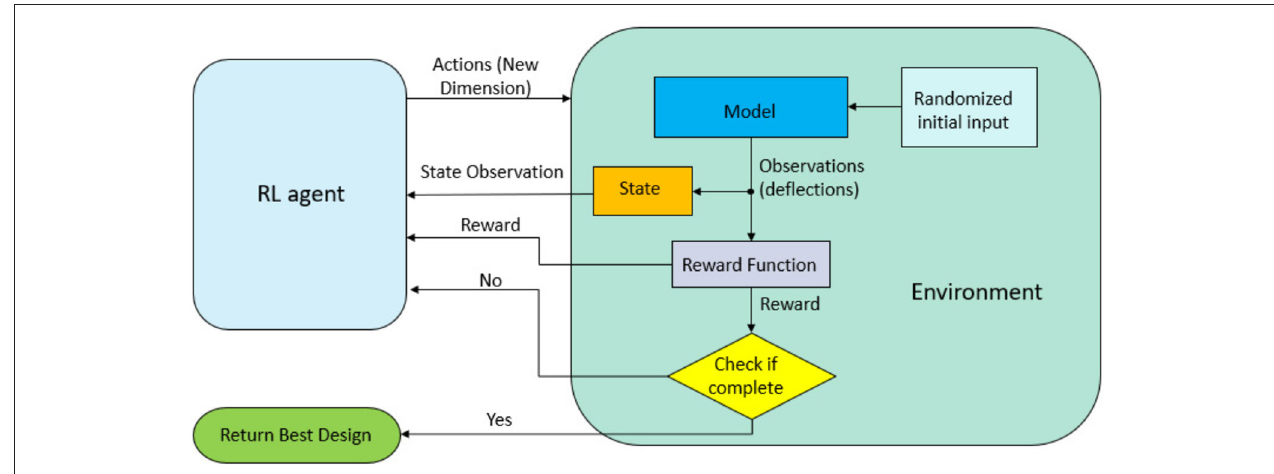
FIGURE 3 | Schematics of the interactions between the RL agent and the environment. Each episode consists of one step. Geometry parameters that dictate the chamber layout are passed from the RL agent as actions. The state observation and a reward signal for indirect supervision are sent back to the RL agent.